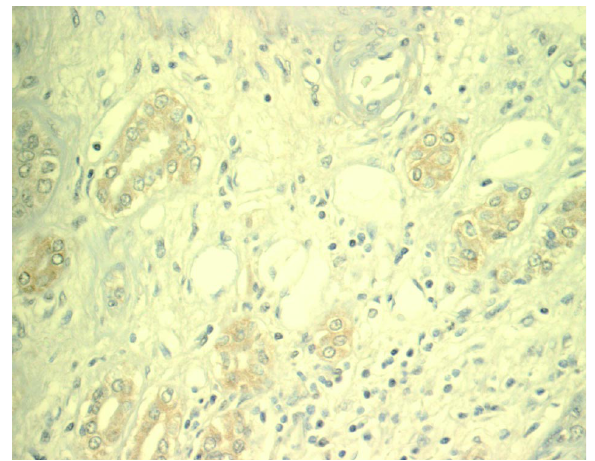
Figure 1 – Immunohistochemistry shows positivity to Ulex Eu- ropean agglutinin 1 lectin, which strongly supports the diagno- sis of